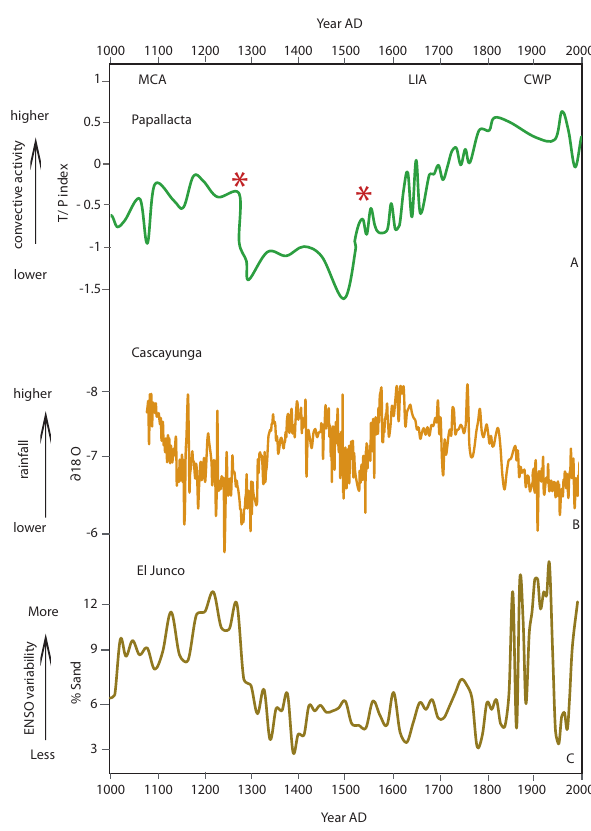
Fig. 7. The past 1000yr in western South America with (A) the Papallacta T/P index of upslope convective activity calculated from the PA 1-08 pollen record; (B) ∂ 18O cal from Cascayunga, Peru, a record of SASM intensity (Reuter et al., 2009), and (C) % sand from El Junco, Galapagos, a record of El Ni˜no frequency (from Conroy et al., 2009). Red stars show volcanic eruptions at